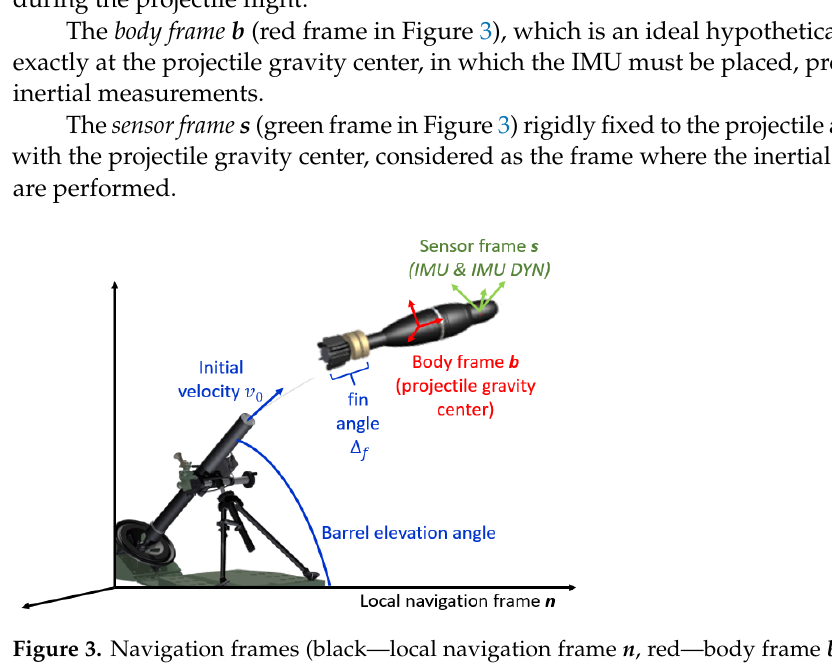
Figure 3. Navigation frames (black—local navigation frame n , red—body frame b , green—sensor frame s ) and flight parameters for a finned projectile (fin angle δ f , initial velocity v 0 , barrel elevation angle α